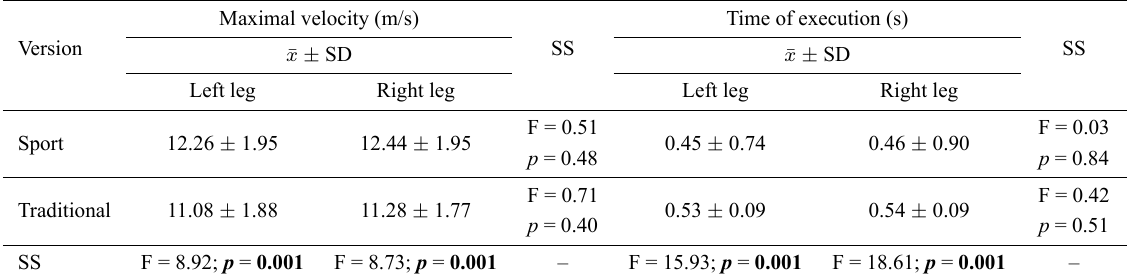
Table 3. Mean values of maximal velocity and time of execution of roundhouse kick in different versions.